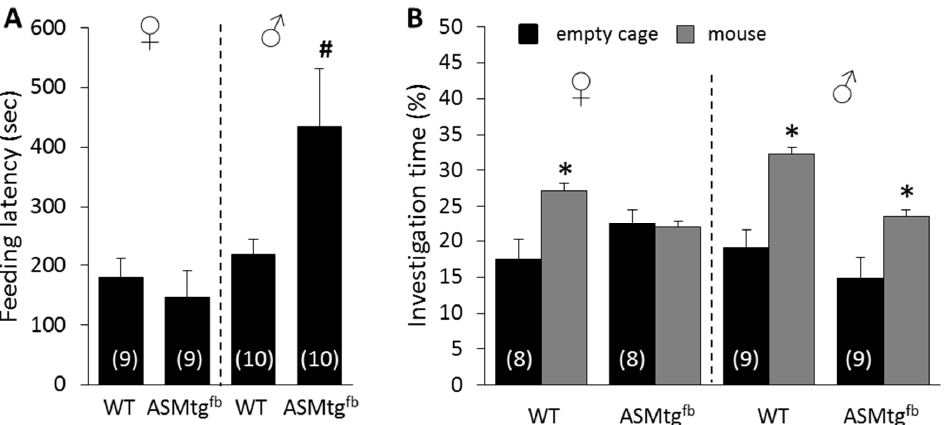
Figure 3. Asm overexpression alters depressive-like and social anxiety-like behavior in a sex-specific way. ( A ). Feeding latency, as an indicator of depressive-like behavior, was assessed in the novelty-suppressed feeding paradigm. Male Asm-tg fb mice showed increased depressive-like behavior compared with WT mice. ( B ). The time of investigation of an unknown mouse compared with that of an empty cage, as an indicator of social anxiety-like behavior, was assessed in the social preference-avoidance test. Female Asm-tg fb mice showed increased social anxiety-like behavior compared with WT mice. Data represent the means + SEM, and numbers in parentheses indicate group sizes. * p < 0.05 versus empty cage; # p < 0.05 versus ♂ WT and ♀ Asm-tg fb .